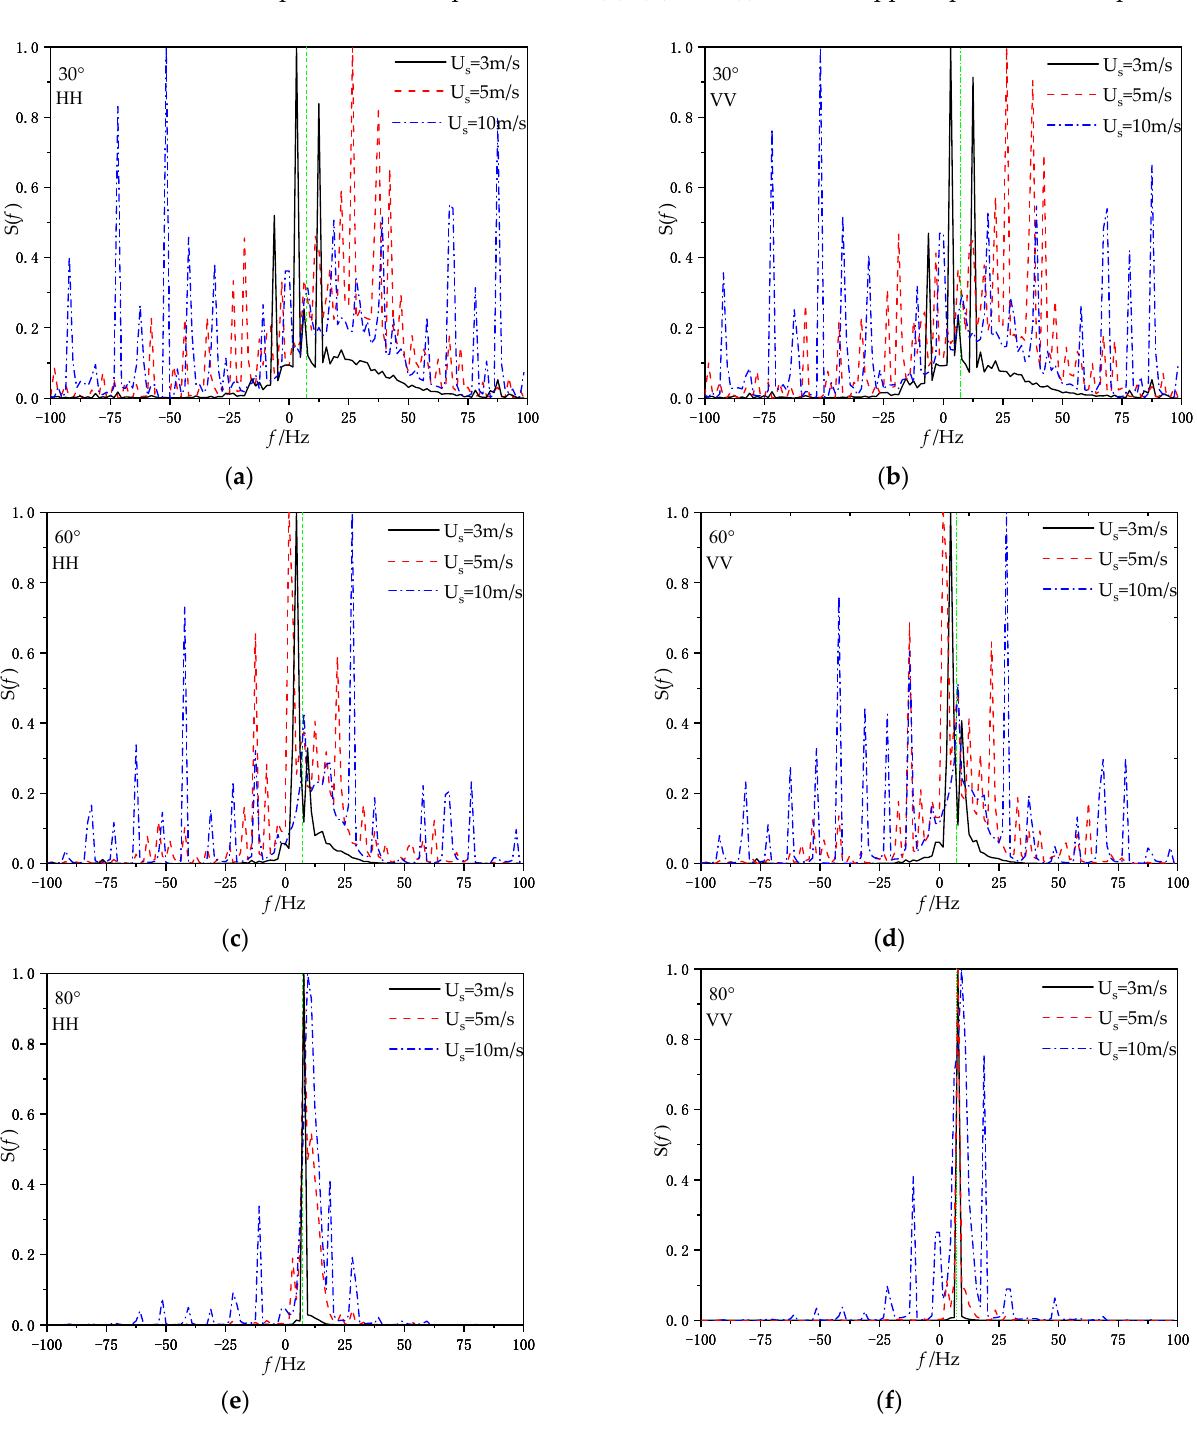
Figure 12. Doppler spectra at different ship speeds: ( a ), ( c ), and ( e ) for the Doppler spectrum at HH polarization; ( b ), ( d ), and ( f ) for the Doppler spectrum at VV polarization. It can be seen from Figure 12 that the main peak of the Doppler spectrum is near Bragg frequency for both HH polarization and VV polarization, and they do not degener- ate due to the increase in ship speed, which indicates that the wake motion is modulated by the sea wave. As can be seen from the figure, with the increase in the incidence angle, the peak value of Doppler farther away from Bragg frequency decreases until the spectral peak disappears, while the peak value of Doppler closer to Bragg frequency almost stays the same. At the same time, it can be observed that the Doppler spectrum broadening of sea surface becomes narrower with the increase in incident angle. With the increase in the ship speed, the main peak of the Doppler spectrum widens and creates new peaks on either side of the Bragg frequency. When the ship speed is less than the wind speed, only a few spectral peaks are generated or no new spectral peaks are generated. When the ship speed is close to and greater than the wind speed, multiple new peaks will be generated in the Doppler spectrum regardless of the incident angle. This shows that when the ship speed is less than the wind speed, the wake has little influence on the sea surface rough- ness; When the ship speed is more than the wind speed, the wake becomes the main factor affecting the sea surface roughness, which is also the reason for the new spectral peak of the Doppler spectrum at large ship speed. Figure 13 gives the Doppler spectra at different wind speeds for incident angle θ i = 80°, wind direction φ w = 0°, and ship speed U s = 5 m/s (a) for the Doppler spectrum at HH polarization, (b) for the Doppler spectrum at VV polarization, (c) for the Doppler spectrum at HV polarization, and (d) for the Doppler spectrum at VH polarization.